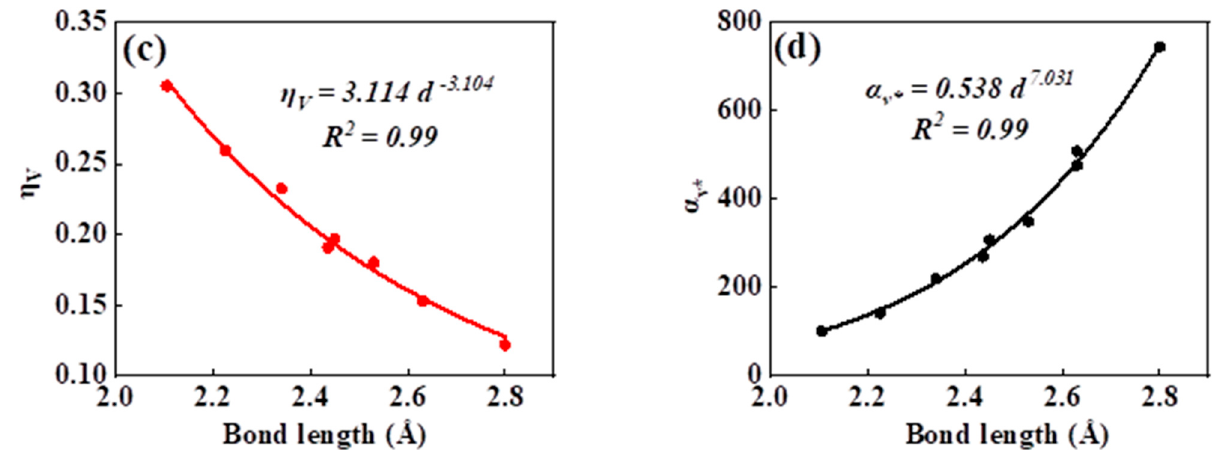
Figure 3. Plot of correlation between the lattice energy, ( a ) bulk modulus, ( b ) chemical hardness density, ( c ) product of electronic polarizability and molar volume, ( d ) and chemical bond length of tetrahedral coordinated crystals of group Ⅱ – Ⅵ .